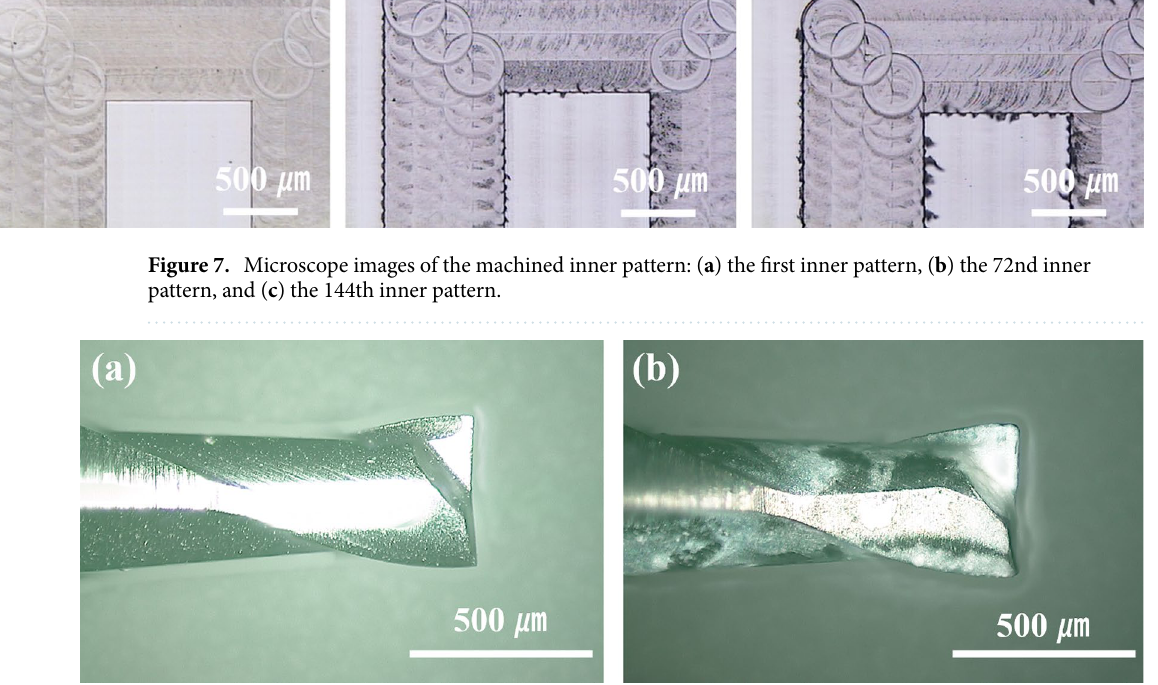
Figure 8. Microscope images of cutting tools before and after machining: ( a ) before machining and ( b ) after machining of the 144th double square